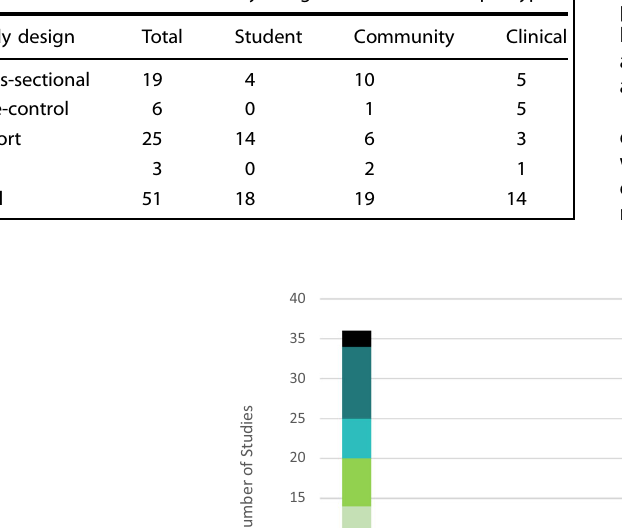
Table 2. The breakdown of study designs within each sample